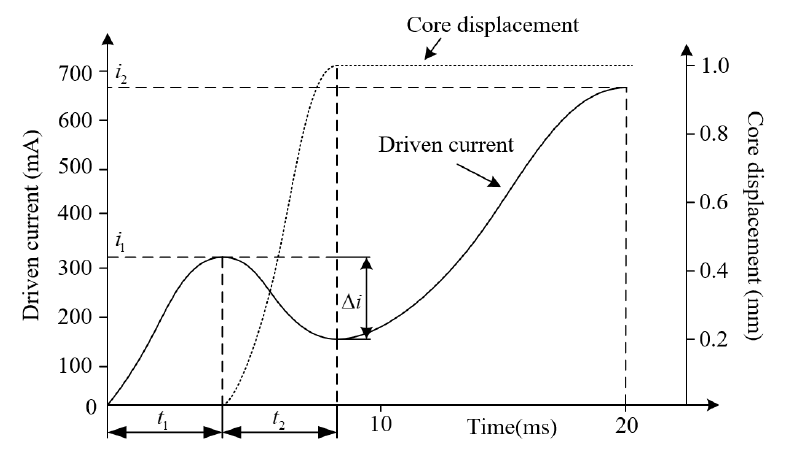
Figure 2. Dynamic driven current and core displacement of the high-speed solenoid valve.